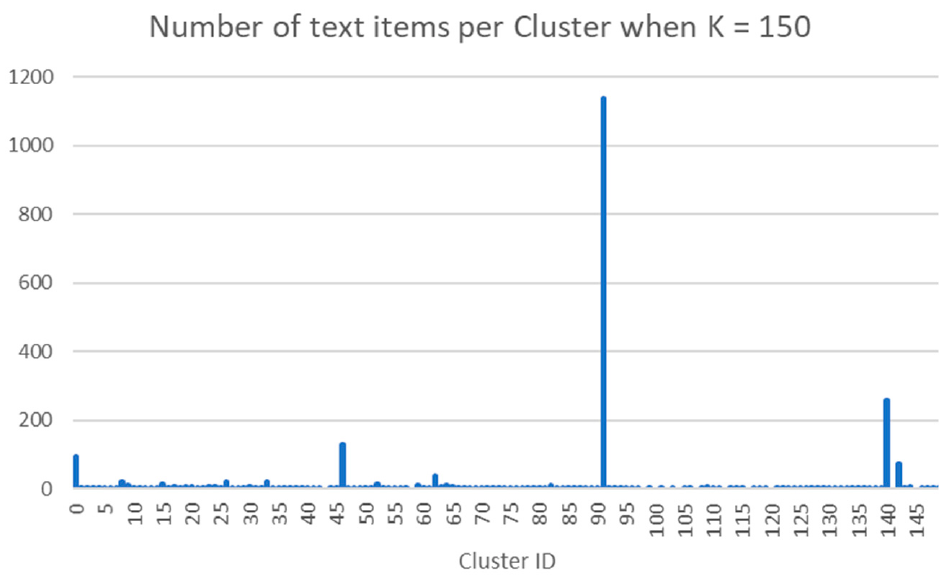
Figure 6. Distribution of LFE dataset when clustered using k -Means where k = 150.